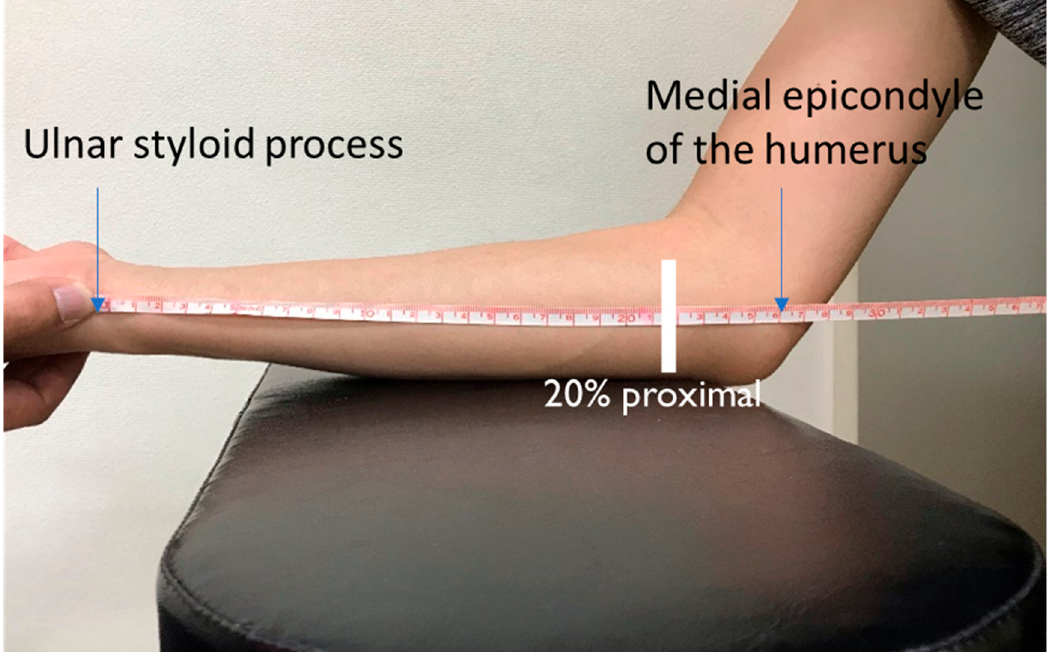
Figure 1. Clinical images at rest and contraction in the pitching arm.